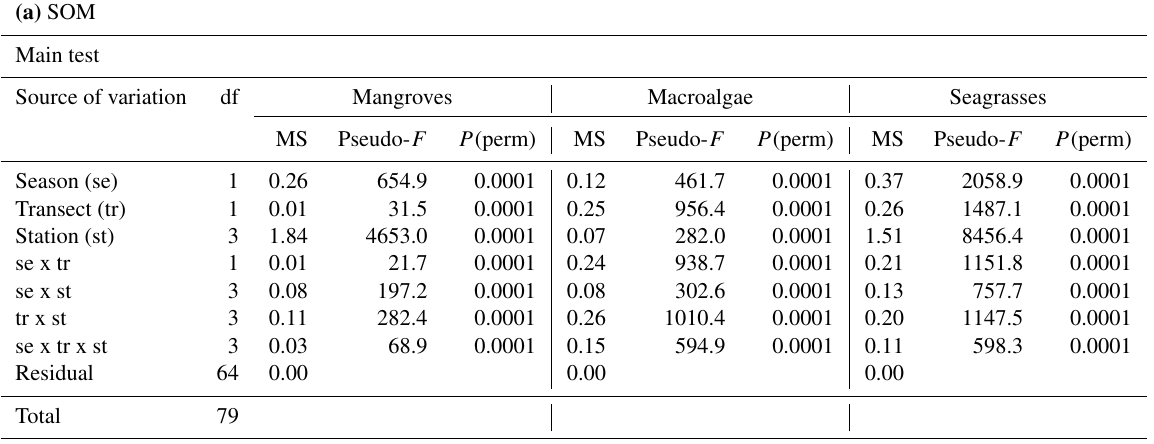
Total 79 Pair-wise tests: term “se x tr x st” for pairs of levels of factor “station”. All the comparisons resulted significant at P (perm) <